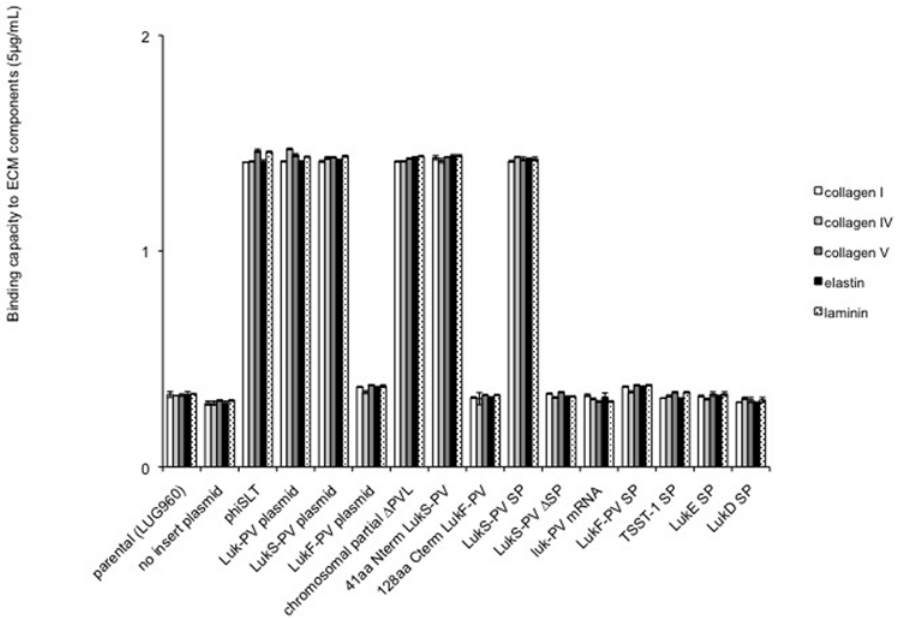
Figure 2. Binding capacity of isogenic strains to ECM components. Isogenic strains of Staphylococcus aureus examined for their binding capacity (Y-axis, absorbance reading at 540 nm) to collagen IV (Sigma) coated on 96-well plates, at concentrations of 5 m g/mL (identical results were obtained at concentrations of 50 m g/mL). Collagen I (white bars); collagen IV (grey bars); collagen V (dark grey bars); elastin (black bars), laminin (dotted bars). Parental (LUG960) indicates the genetic background in which all genetic modifications were made as follows: no insert plasmid, plasmid vector with no insert; phiSLT, lysogenization with phiSLT; Luk-PV plasmid, plasmid encoding for luk S-PV and luk F-PV; LukS-PV plasmid, plasmid encoding for lukS -PV; LukF-PV, plasmid encoding lukF -PV; chromosomal partial D PVL, partial deletion of the chromosomal luk -PV operon; 41aa Nterm LukS-PV, plasmid encoding for the first 41 amino acids of premature LukS-PV; 128aa Cterm LukF-PV, plasmid encoding for the last 128 amino acids of premature LukF-PV; LukS-PV SP, plasmid encoding the LukS-PV signal peptide; LukS-PV D SP, plasmid encoding LukS-PV without signal peptide; luk -PV mRNA, plasmid encoding for the luk -PV operon mRNA devoid of start codon; LukF-PV SP, plasmid encoding the LukF-PV signal peptide; TSST-1 SP, plasmid encoding the TSST-1 signal peptide; LukE-SP, plasmid encoding for the LukE signal peptide; LukD-SP; plasmid encoding for the LukD signal peptide. The vertical lines indicate the standard deviation.